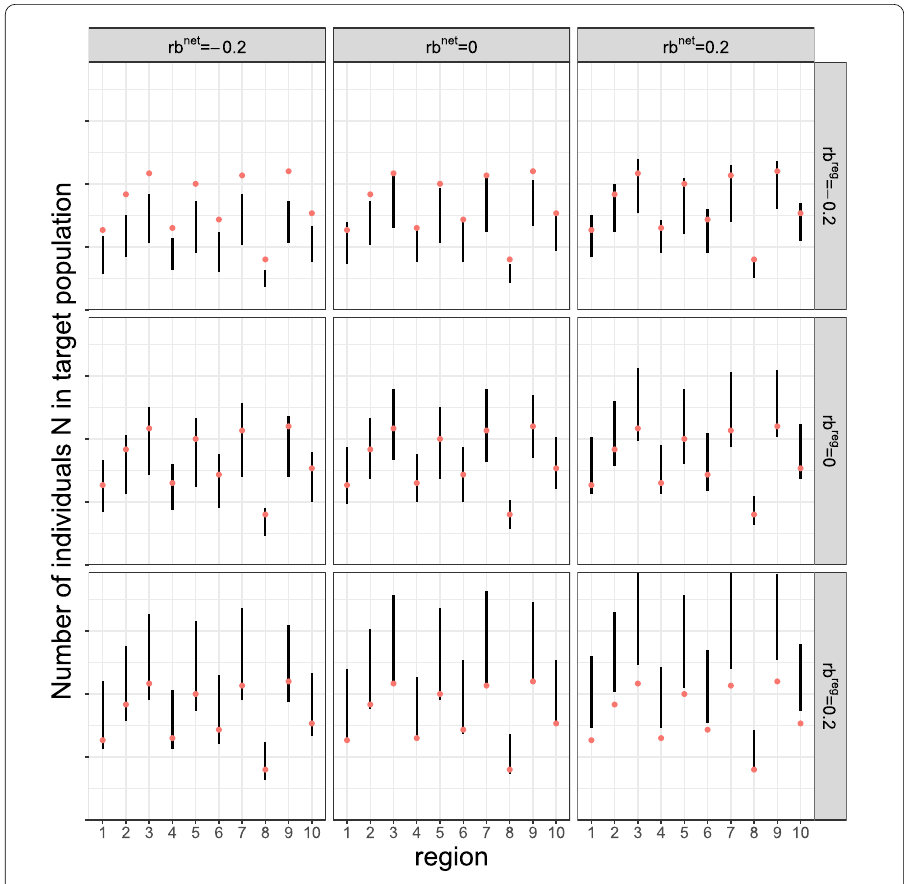
Figure 16 Credible intervals for the initial number of individuals N 0 per region. Credible intervals (prob = 95%) for the initial number of individuals N 0 per region compared to true values (in red) computed according to the distribution in eq. (35) with the RSS geolocation model and uniform prior and different values of rb net and rb reg ( cv reg =